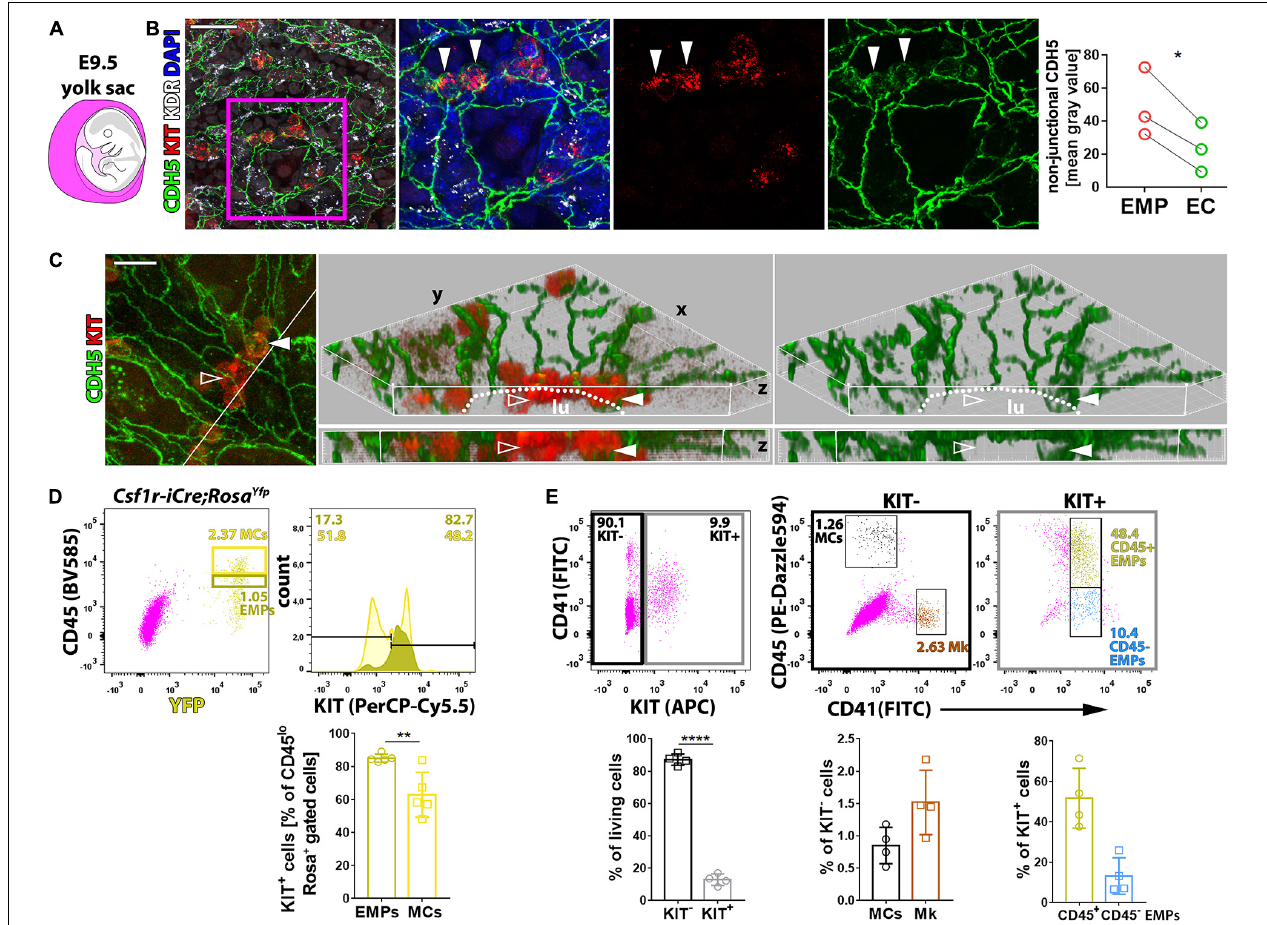
FIGURE 1 | KIT marks EMPs budding from hemogenic endothelium. (A) Schematic representation of an E9.5 mouse embryo surrounded by the yolk sac, shown in purple. (B,C) Whole-mount labeling of E9.5 mouse yolk sacs with the indicated markers ( n = 3). The dot plot represents the staining intensity (mean gray value) for CDH5 in the cytoplasm of KIT + EMPs and KIT − ECs; each data point represents the average value from at least seven cells in > 2 fields of view from one yolk sac; * p < 0.05 (paired Student’s t -test). The white line in the left panel in (C) marks the clipping plane for the 3D-rendered lateral views in the center and right panels; white arrowheads indicate KIT + CDH5 + budding EMPs, empty arrowheads indicate KIT + CDH5 − EMPs in the vessel lumen; the dotted lines indicate the lumen (lu); scale bars: 50 µ m (B) , 20 µ m (C) . (D) Flow cytometry analysis of single living cells from E9.5 Csf1r-iCre;Rosa Yfp or Rosa tdTom mouse yolk sacs with the indicated markers ( n = 5). The dark and bright yellow boxes in the scatter plot indicate the gates used to quantify the percentage of KIT + cells in the populations containing putative EMPs (CD45 low YFP + or TdTomato + ) and myeloid cells (MCs, CD45 high YFP + or TdTomato + ; a presentative experiment is shown for Rosa Yfp ), respectively. Pooled data for Rosa Yfp or Rosa tdTom experiments are shown as mean ± SD; each data point represents the value from one embryo; ** p < 0.01 (paired Student’s t -test). (E) Flow cytometry analysis of single living cells from E9.5 mouse yolk sacs with the indicated markers ( n = 4). The black and gray boxes in the scatter plot on the left-hand side indicate the gates used to quantify the proportion of KIT + and KIT − cells, which were further analyzed, as shown in scatter plots in the center and on the right-hand side, respectively. The color-coded annotation indicates the gates used to determine the percentage of the KIT − MCs and megakaryoblasts (Mk) as well as the KIT + CD45 + and CD45 − putative